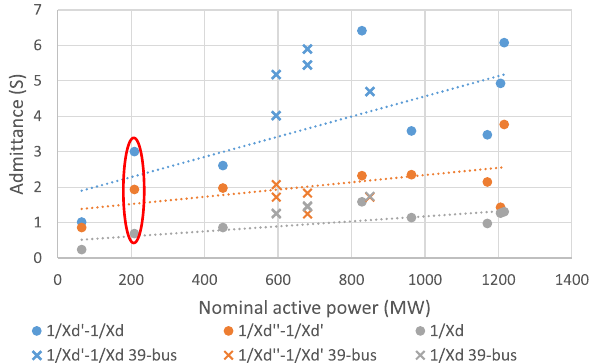
Fig. 10. Evolution of nuclear unit’s admittance characteris- tics of short-circuit behaviour, as a function of nominal active power in the 39-bus grid and according to [19].